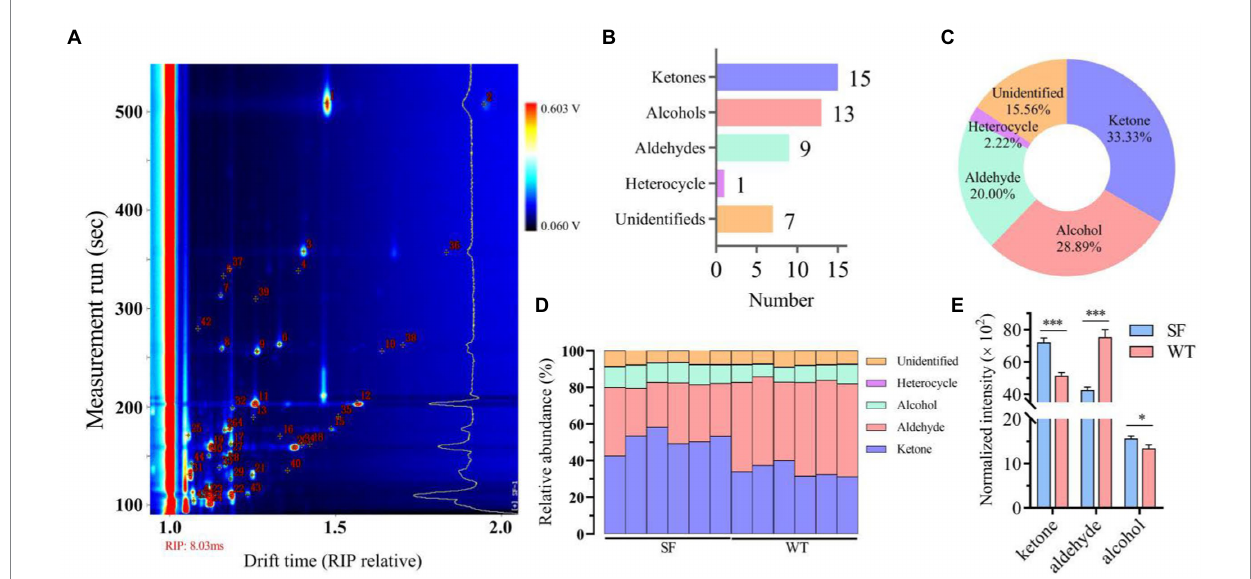
FIGURE 1 VOC profiles of donkey meats from two strains. Number of volatile compounds (A) . Number (B) and percentage (C) of volatile compound categories. Percentages (D) and concentrations (E) of volatiles compound typed in donkey meats from the two strains. Data presented as mean ± SEM ( n = 6), * p < 0.05, *** p < 0.001. SF, Sanfen; WT,